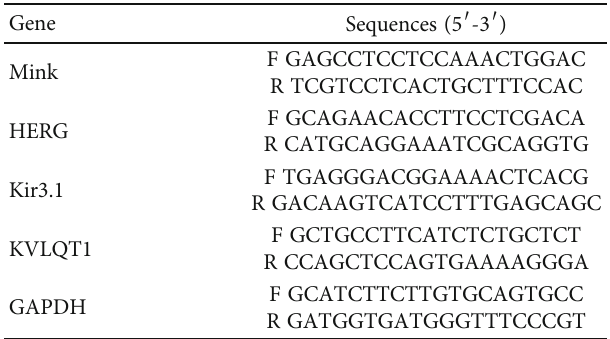
Table 2: Comparison of physiological indexes of rats ( (cid:1) x ± SD ).